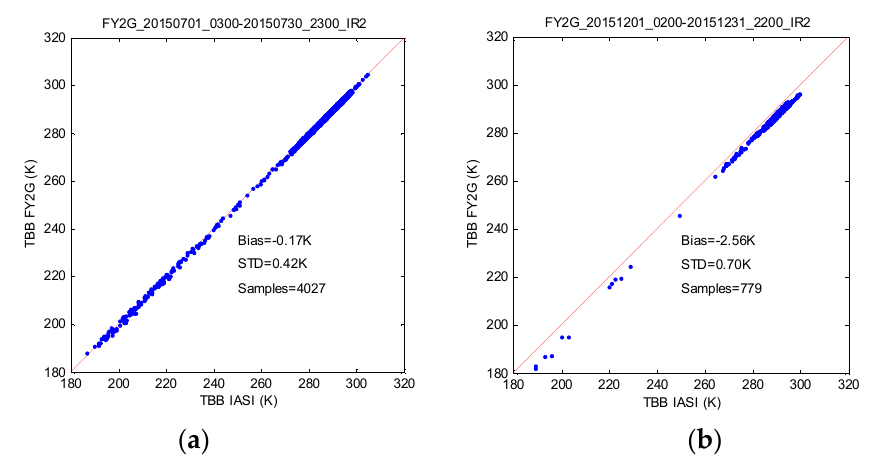
Figure 1. Typical scatter diagram comparison of the calibration bias in the IR2 band of the FY-2G